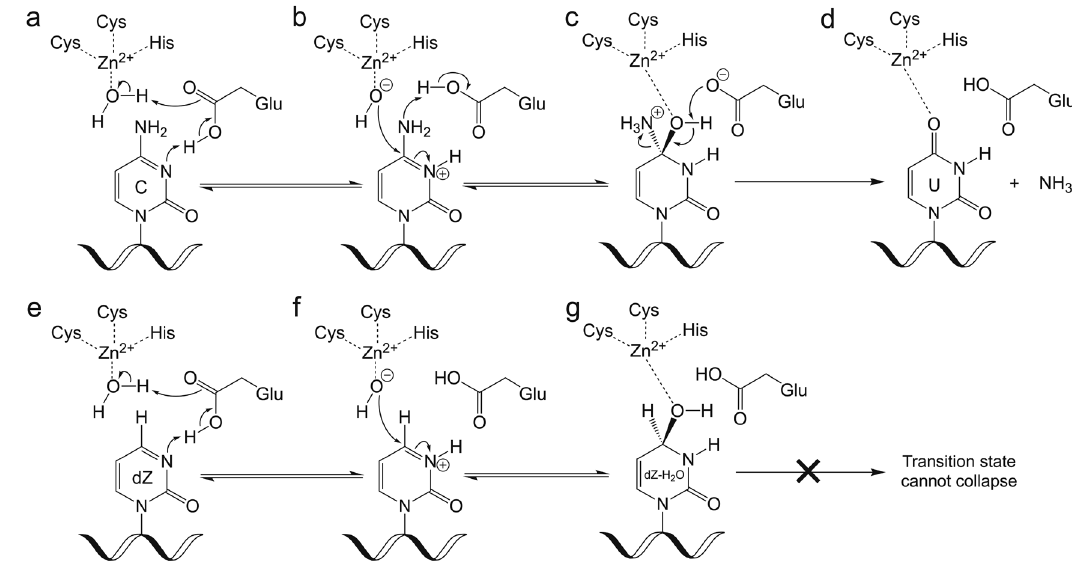
Fig. 2 | Mechanism of deamination by A3 enzymes on dC and dZ showing key tetrahedral intermediates. Top panel, cytidine nucleobase; a Key active site Glu protonates the N3 nitrogen and absorbs a proton from the Zn-coordinated water molecule. b Zn-coordinated hydroxide ion attacks the activated C4 carbon as the Glu protonates the C4-amine. c The key tetrahedral intermediate collapses as the Glu absorbs the C4-OH proton, a carbonyl is formed, and ammonia leaves.